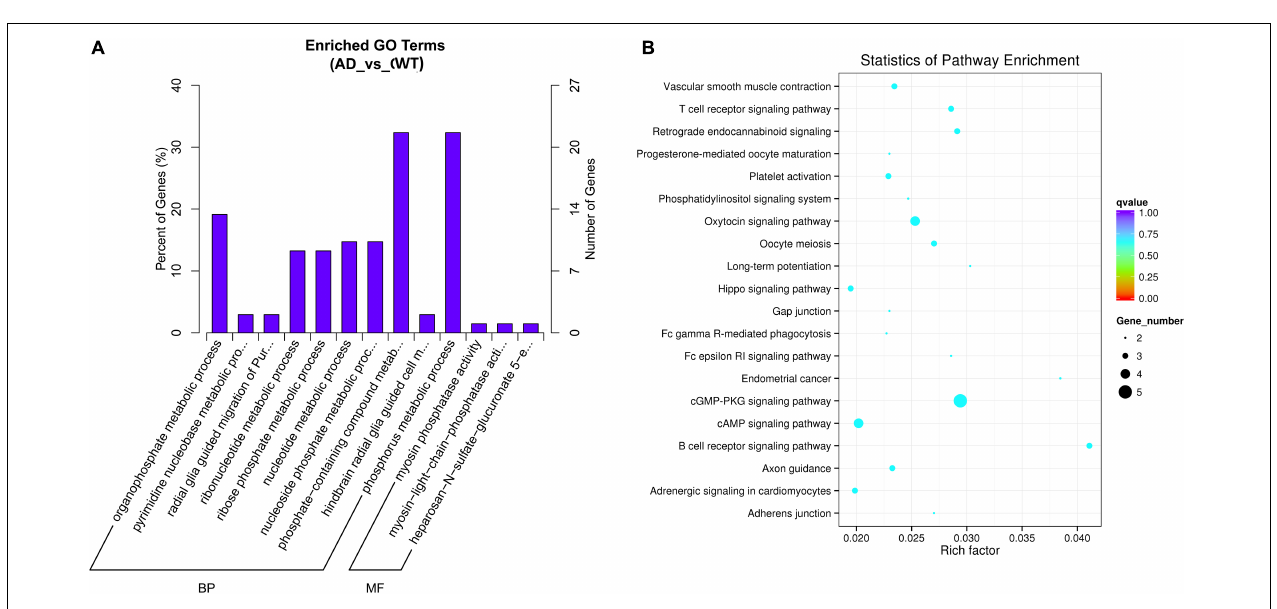
FIGURE 3 | (A) Gene Ontology (GO) Enrichment Annotations of pathological progression of AD: Biological Process (BP) and Molecular Function (MF). (B) Significantly Enriched Kyoto Encyclopedia of Genes and Genomes (KEGG). The aberrantly expressed circRNAs in distinct aspects of AD pathology.